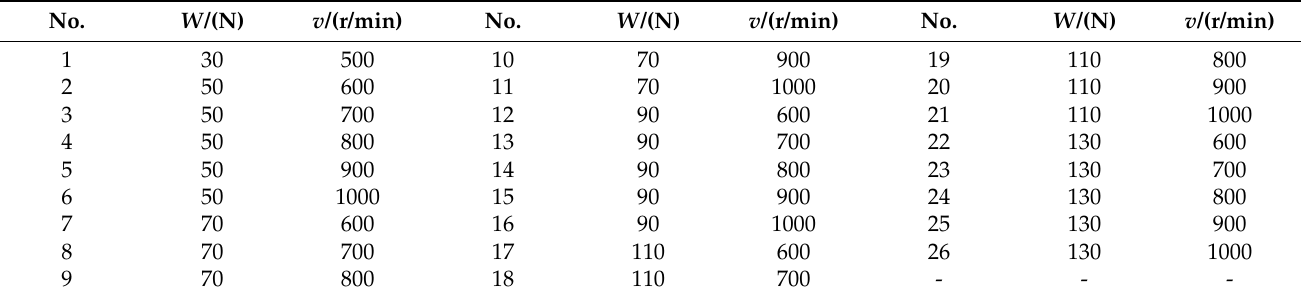
Table 2. Friction parameters of friction conditions.